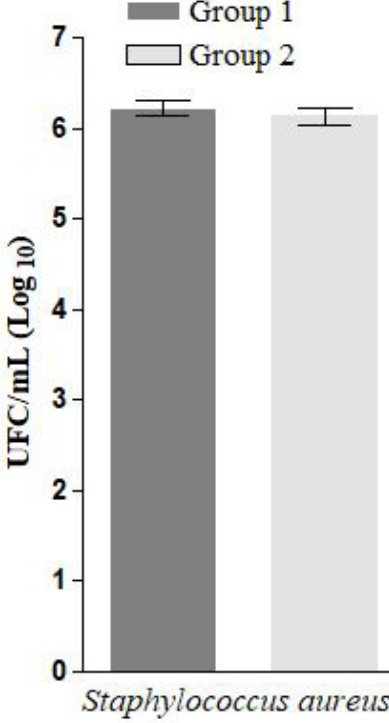
Figure 12. Representative SEM images of cells on Group 1 – Nanotubes of TiO after 1 and 7 days of culture.